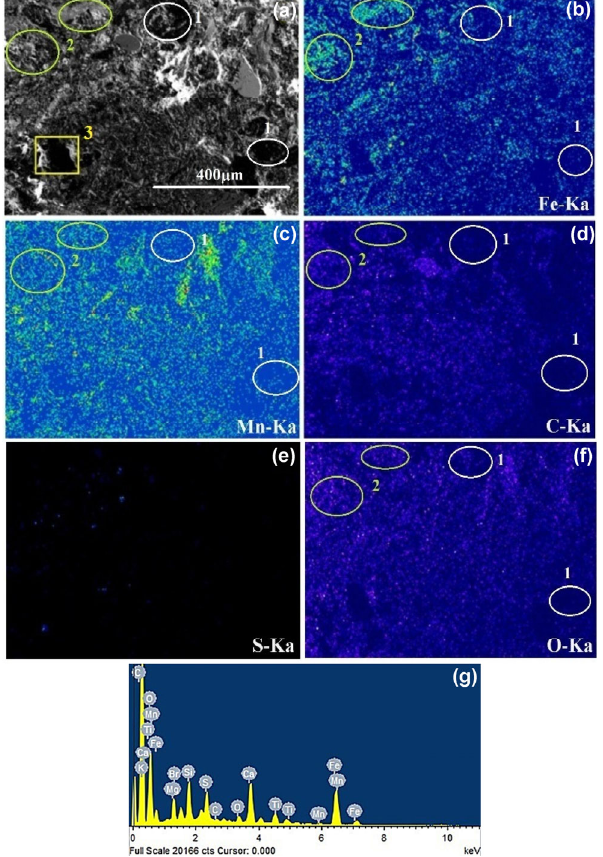
Fig. 13 Worn surfaces of the FM02 composites (a) electron image, (b)–(f) electron images with elemental mapping, and (g) EDAX spectra representing primary plateau